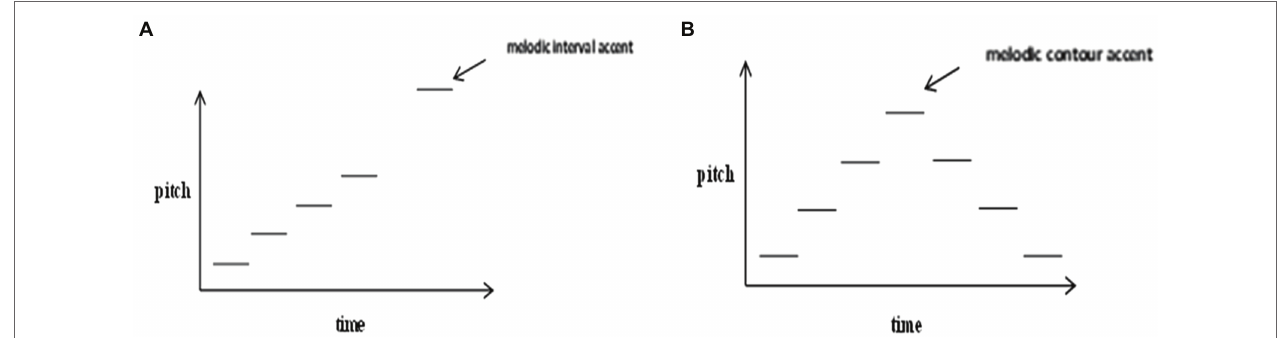
FIGURE 2 | Melodic interval accent (A) and contour accent (B)